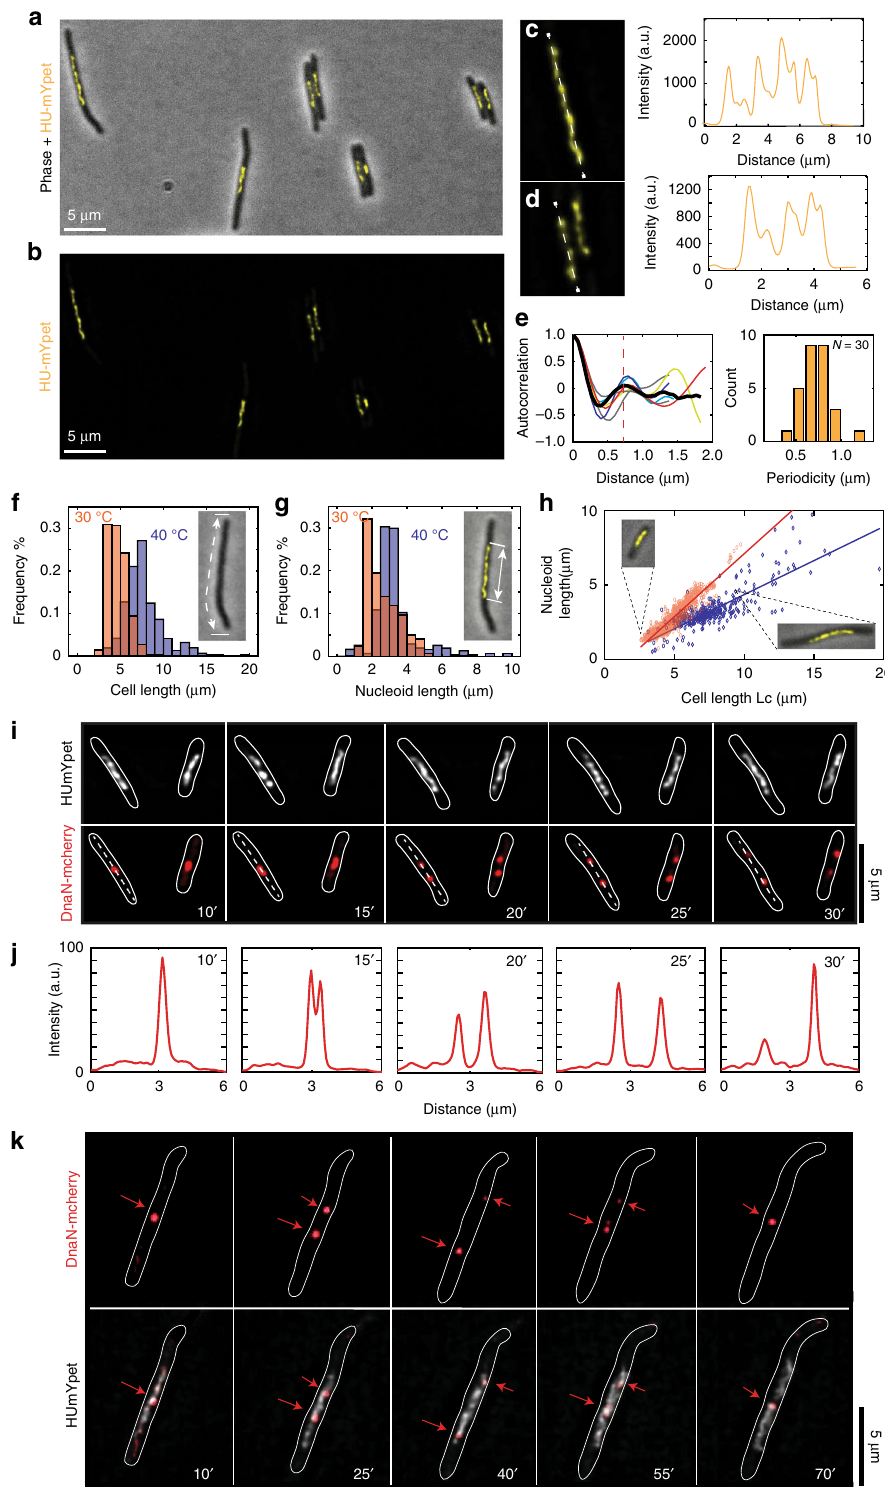
fi nishing the replication (Fig. 2k) disassembled, reducing the observed number of foci per cell at replication termination. Independently moving replisomes form a replication bubble . To visualize the replication bubble, we used the same dnaCts cells with the labelled DNA and replisome, but now added the